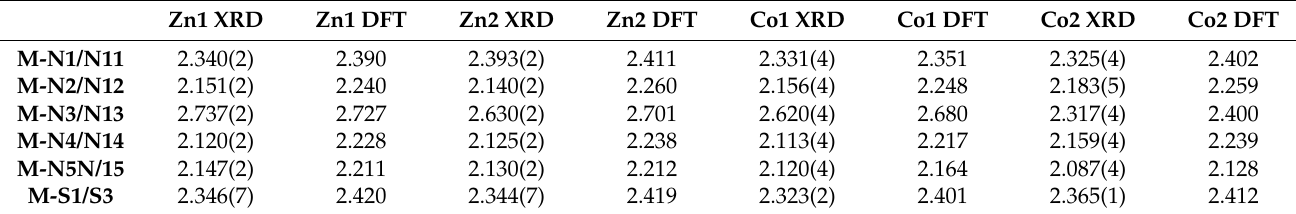
Table 4. Selected bond lengths (Å) of the optimised and XRD structures of [Co1H L ] + , [Co2H L ] + , [Zn1H L ] + and [Zn2H L ] +